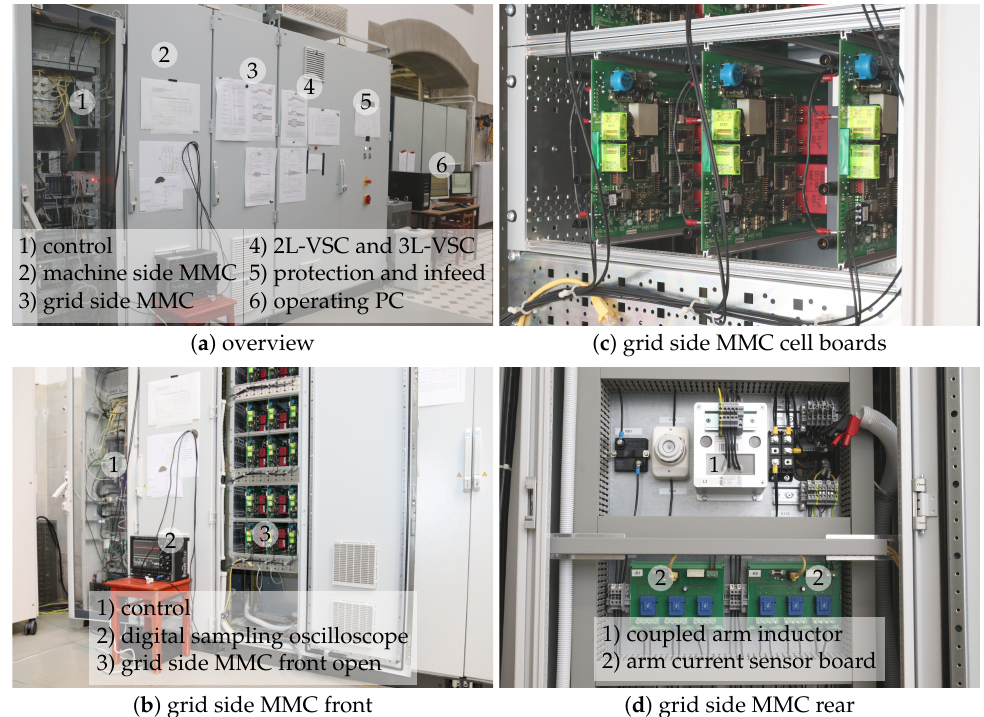
Figure 6. Pictures of the low-voltage test-bench: ( a ) overview, ( b ) MMC front view, ( c ) MMC cells, ( d ) MMC rear view. Each cell board holds two cells. Only the grid side MMC and the 3L-VSC (three-level voltage source converter) were used in the experiments. The grid emulator (Cinergia GE-AC-15) was connected via the infeed cabinet, denoted 5 in ( a